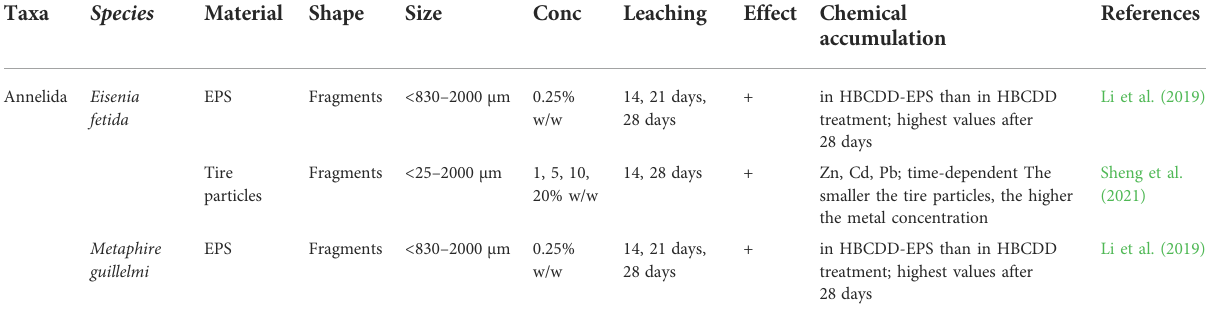
TABLE 2 Accumulation of leached